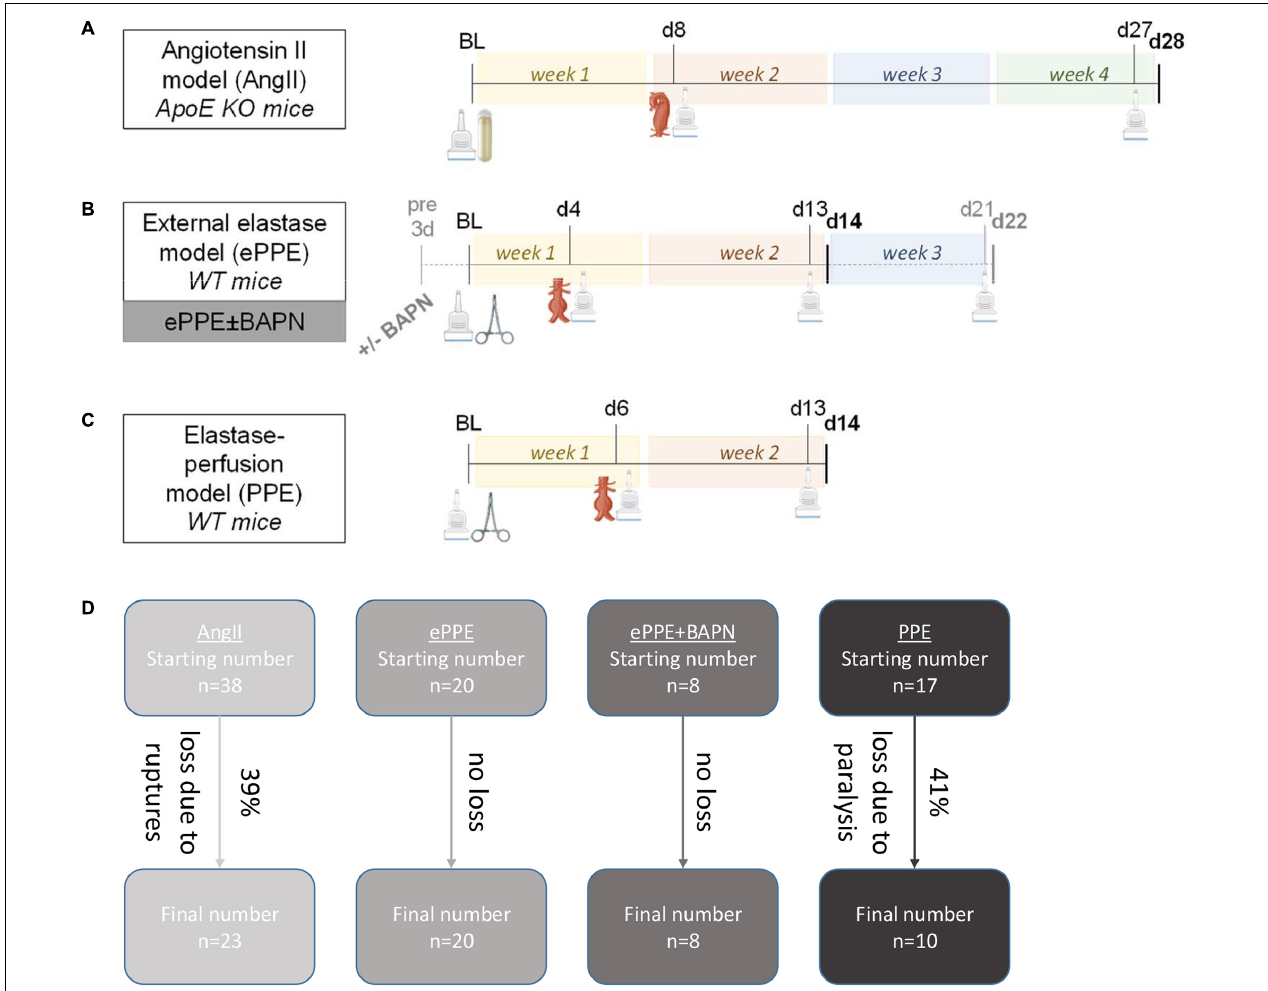
FIGURE 1 | Experimental design of AAA mouse models. Experimental steps and time lines are illustrated for the (A) AngII model, (B) ePPE ± BAPN models and (C) PPE model. Time points of 3D US analysis are indicated by the scanner icon, while interventions at baseline to trigger AAA development are illustrated by osmotic pump for the AngII model or by surgical clamp for the elastase-based models. Formed aneurysms were either of suprarenal (AngII) or infrarenal (elastase models) localization. For the ePPE + BAPN model (gray lettering), BAPN was administered from 3 days before surgical intervention until day 22 as opposed to the ePPE model without BAPN which was terminated on day 14. (D) The flow chart illustrates starting numbers and animal losses in the four mouse models resulting in the final number of mice included in the follow-up time